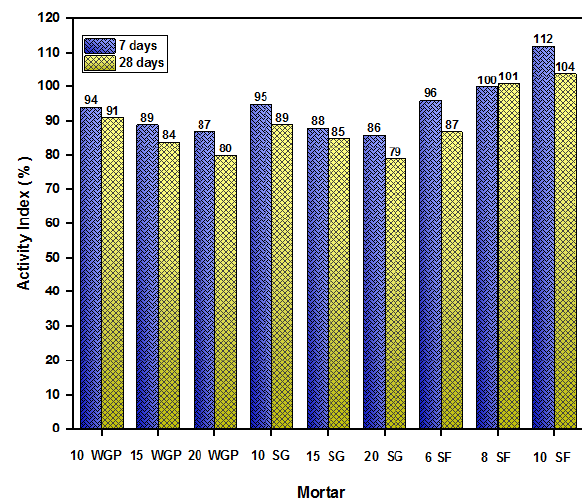
Figure 2: Activity index at 7 and 28